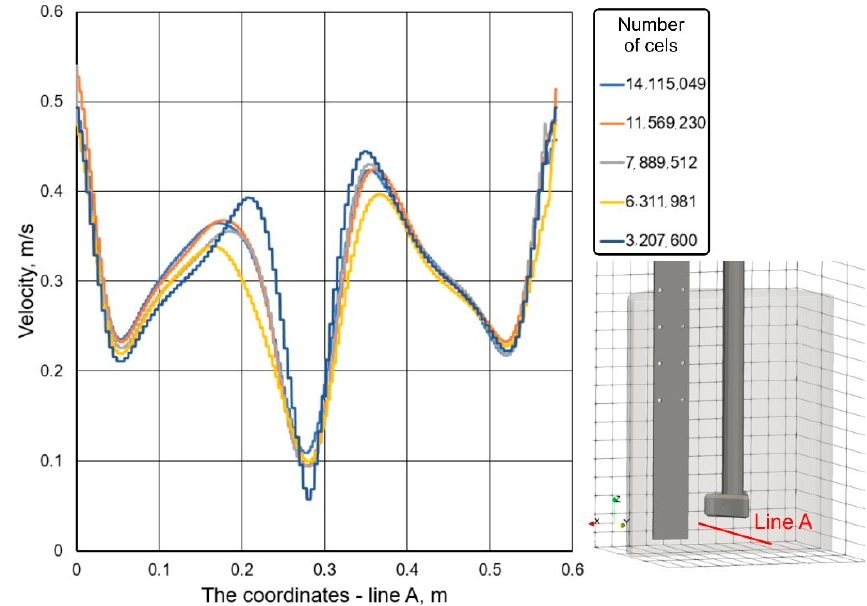
Figure 6. The velocity of the water depending on the size of the computational grid.